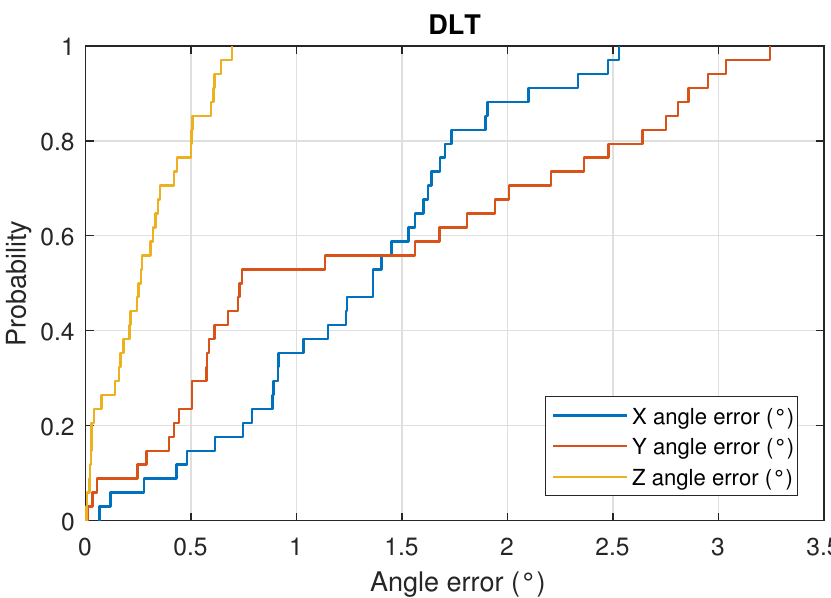
Figure 18. CDF of the angle error in the 3 axes using DLT. With respect to the DLT method, in 80% of the cases, the z-axis angle error is less than 0.5 ◦ , the x-axis angle error is less than 1.7 ◦ and the y-axis angle error is less than 2.5 ◦ . Using the CPC method, the results are better, obtaining in 80% of the cases that the angle error of the z-axis is less than 0.35 ◦ , the x-axis angle error is less than 0.5 ◦ and the y-axis error angle is less than 0.55 ◦ .